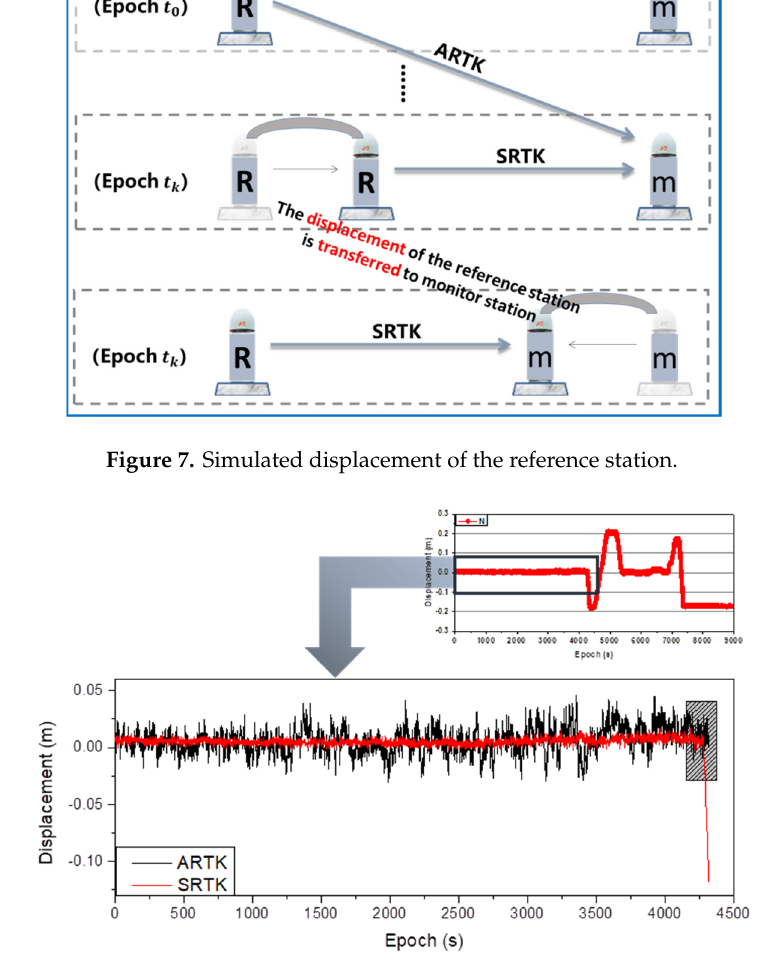
Figure 8. Epoch in which the displacement of the reference station is detected to exceed the threshold value.